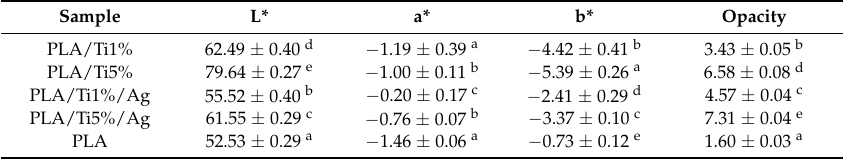
Table 2. The color properties and opacity of pure PLA and PLA nano-blend films.